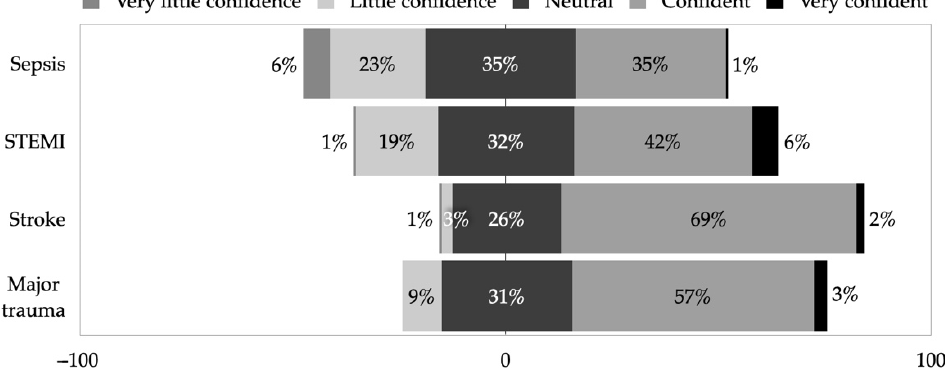
Figure 2. EMS staff’s evaluation of their confidence dealing with time-critical conditions.